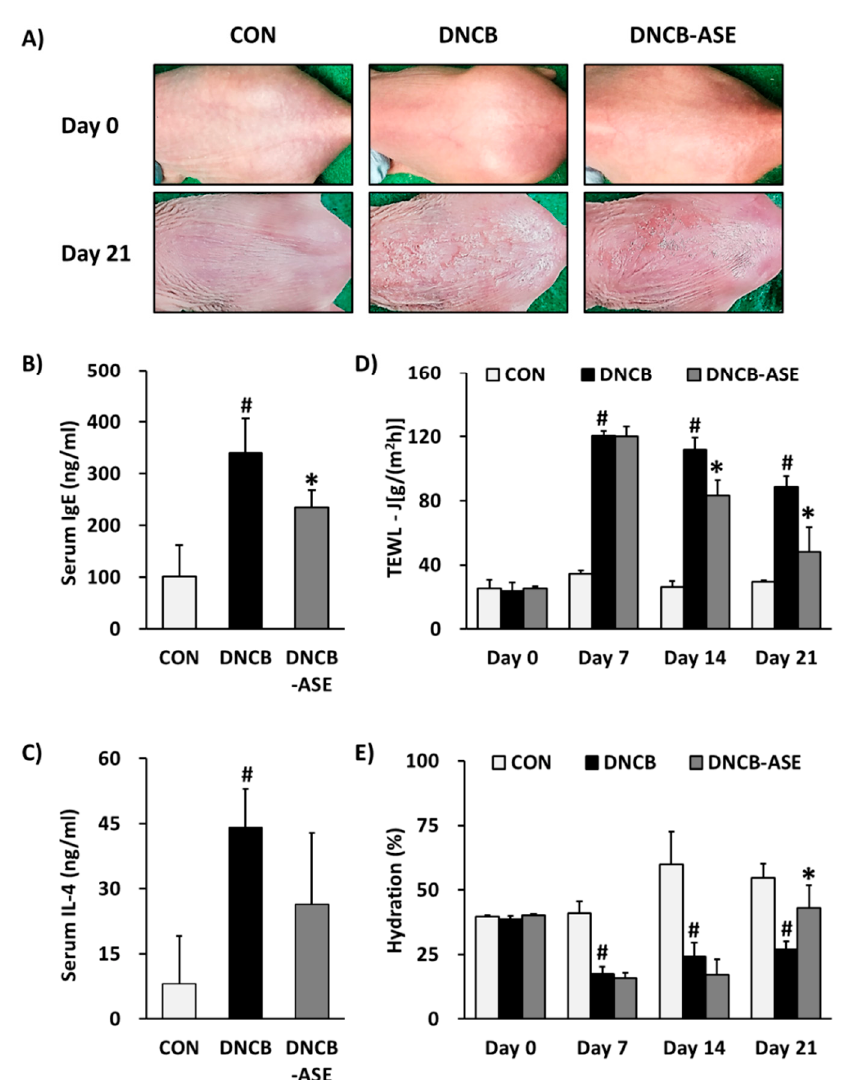
Figure 2. ASE-ameliorated pathological changes in the skin of DNCB-induced atopic hairless mice. Clinical features of AD-like skin lesions ( A ). Concentration of serum IgE ( B ). Concentration of serum IL-4 ( C ). Transepidermal water loss (TEWL) values ( D ). Level of skin hydration ( E ). Data are presented as the mean ± SD, and were analyzed using a one-way ANOVA and a Tukey (cid:48) s multiple comparisons post hoc analysis between the DNCB-induced group (DNCB) and the other groups (CON, DNCB-ASE). # p < 0.05 significantly greater than CON. * p < 0.05 significantly lower than DNCB-ASE. CON, normal control group; DNCB: DNCB-induced group, DNCB-ASE: DNCB and acorn shell extract-treated